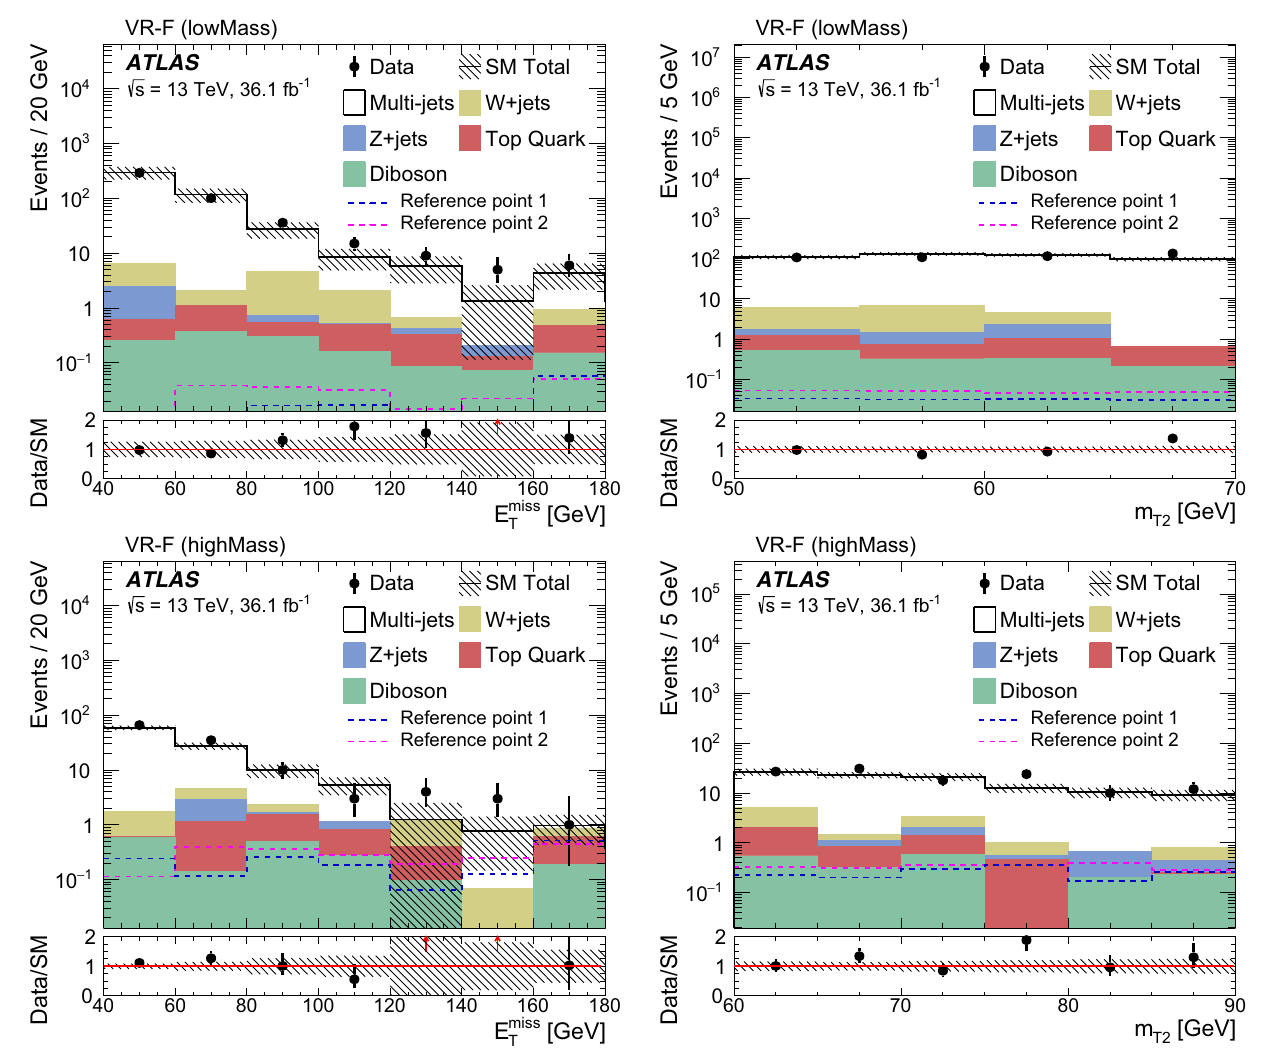
Fig. 3 The E miss T (left) and m T2 (right) distributions in the multi-jet background VR-F for SR-lowMass (top) and VR-F for SR-highMass (bottom). The stacked histograms show the contribution of the non- multi-jet SM backgrounds from MC simulation. The multi-jet contri- bution is estimated from data using the ABCD method. The hatched